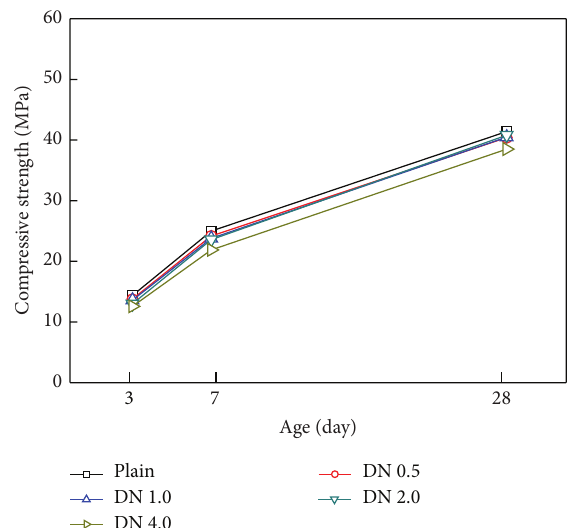
Figure 11: Drying shrinkage length change by age for varying amounts of shrinkage reducing